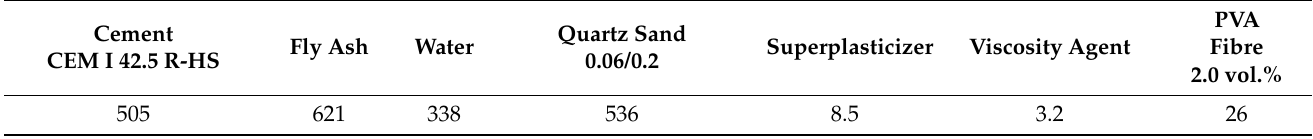
Table 1. Composition of the SHCC under investigation, in kg/m 3